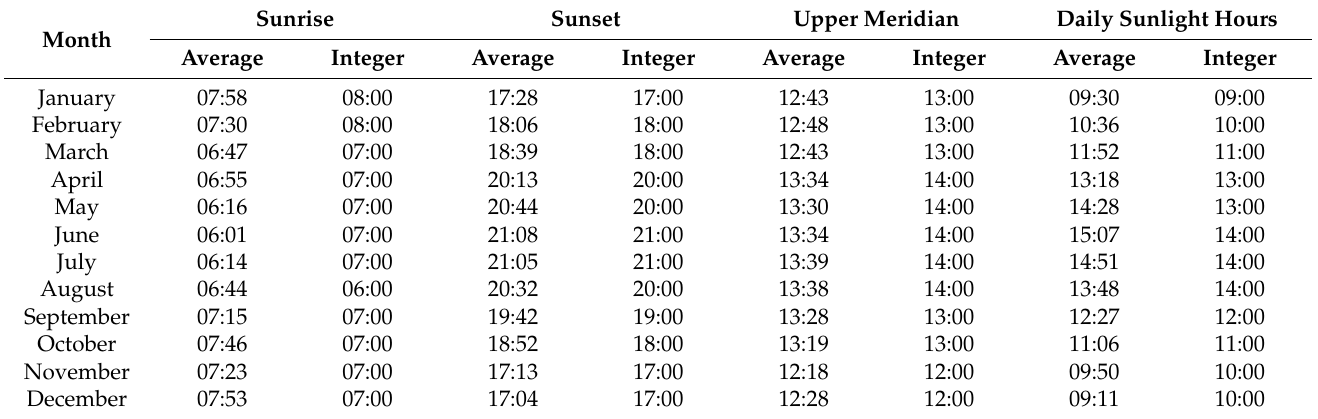
Table 2. Monthly average values for sunrise, sunset, and daily sunlight hours.